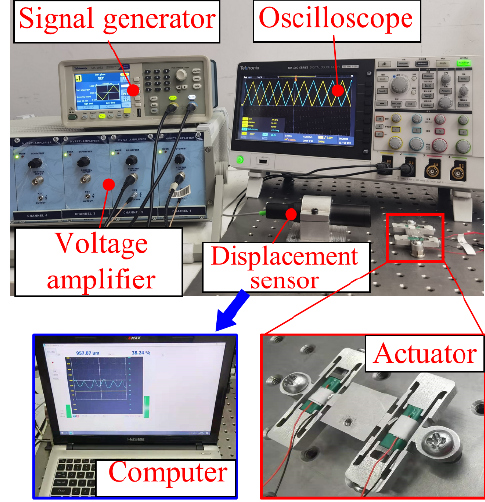
Figure 8. Experimental setup.